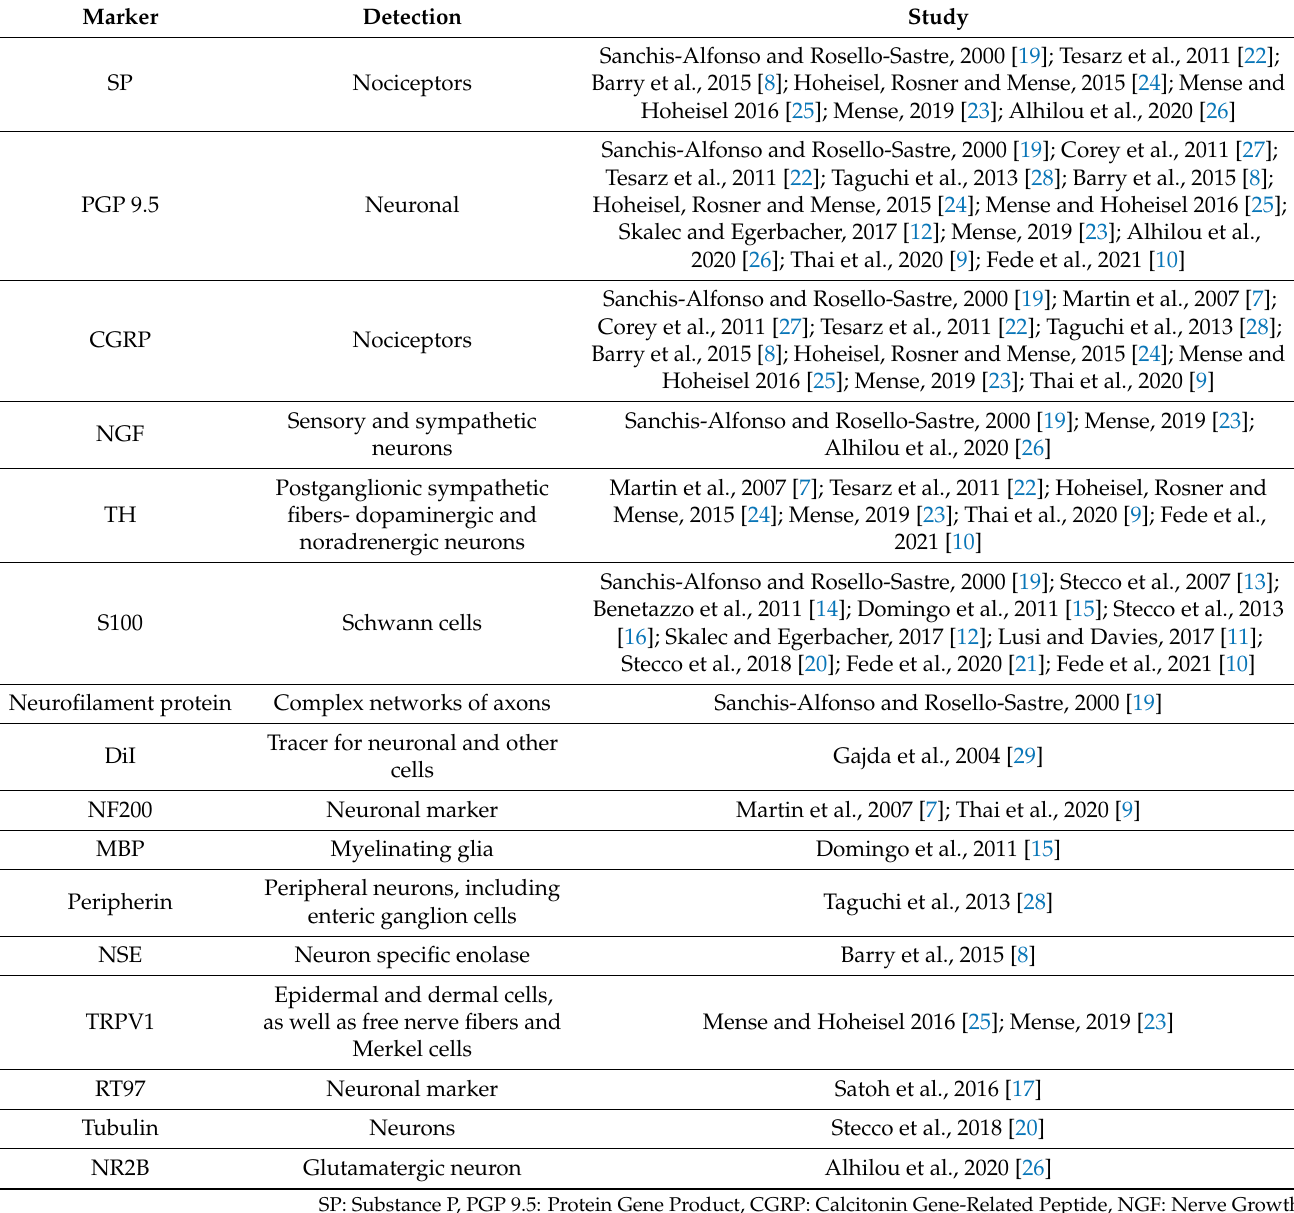
Table 1. List of immunohistochemical markers, targets, and